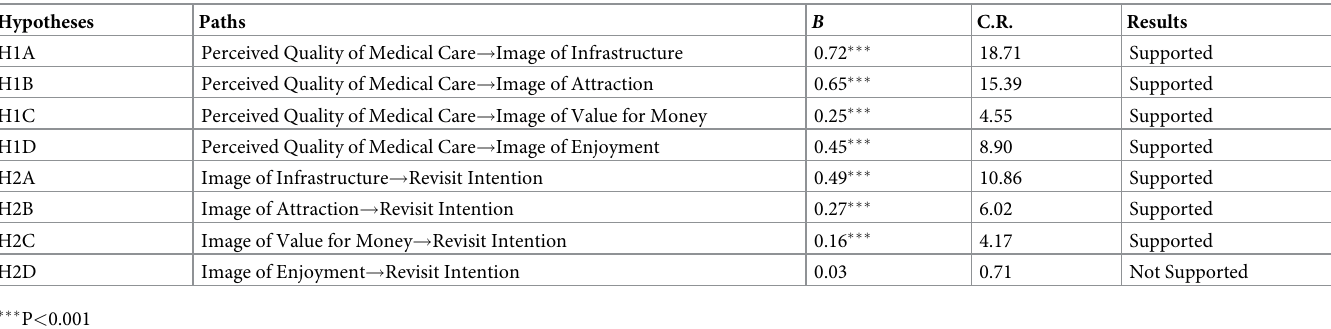
Table 3. Results of path analysis.